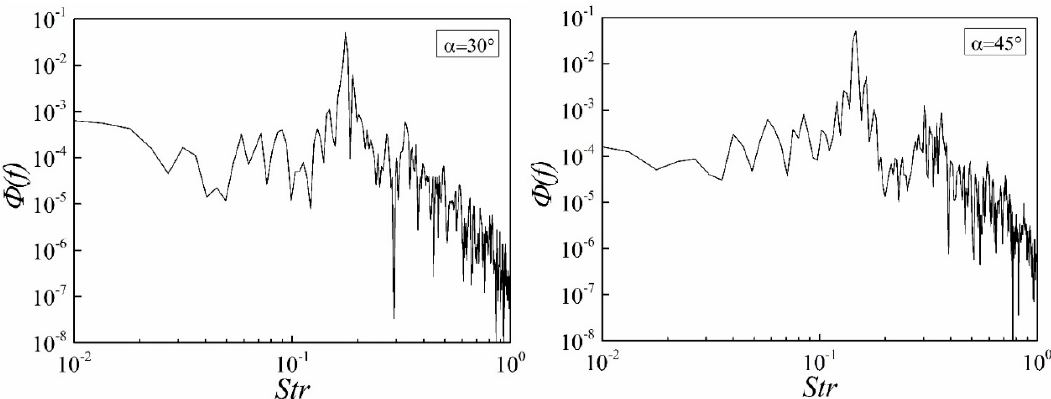
Figure 17. Power spectra of segmental lift coefficient at yaw angles of 30 ° and 45 ° .